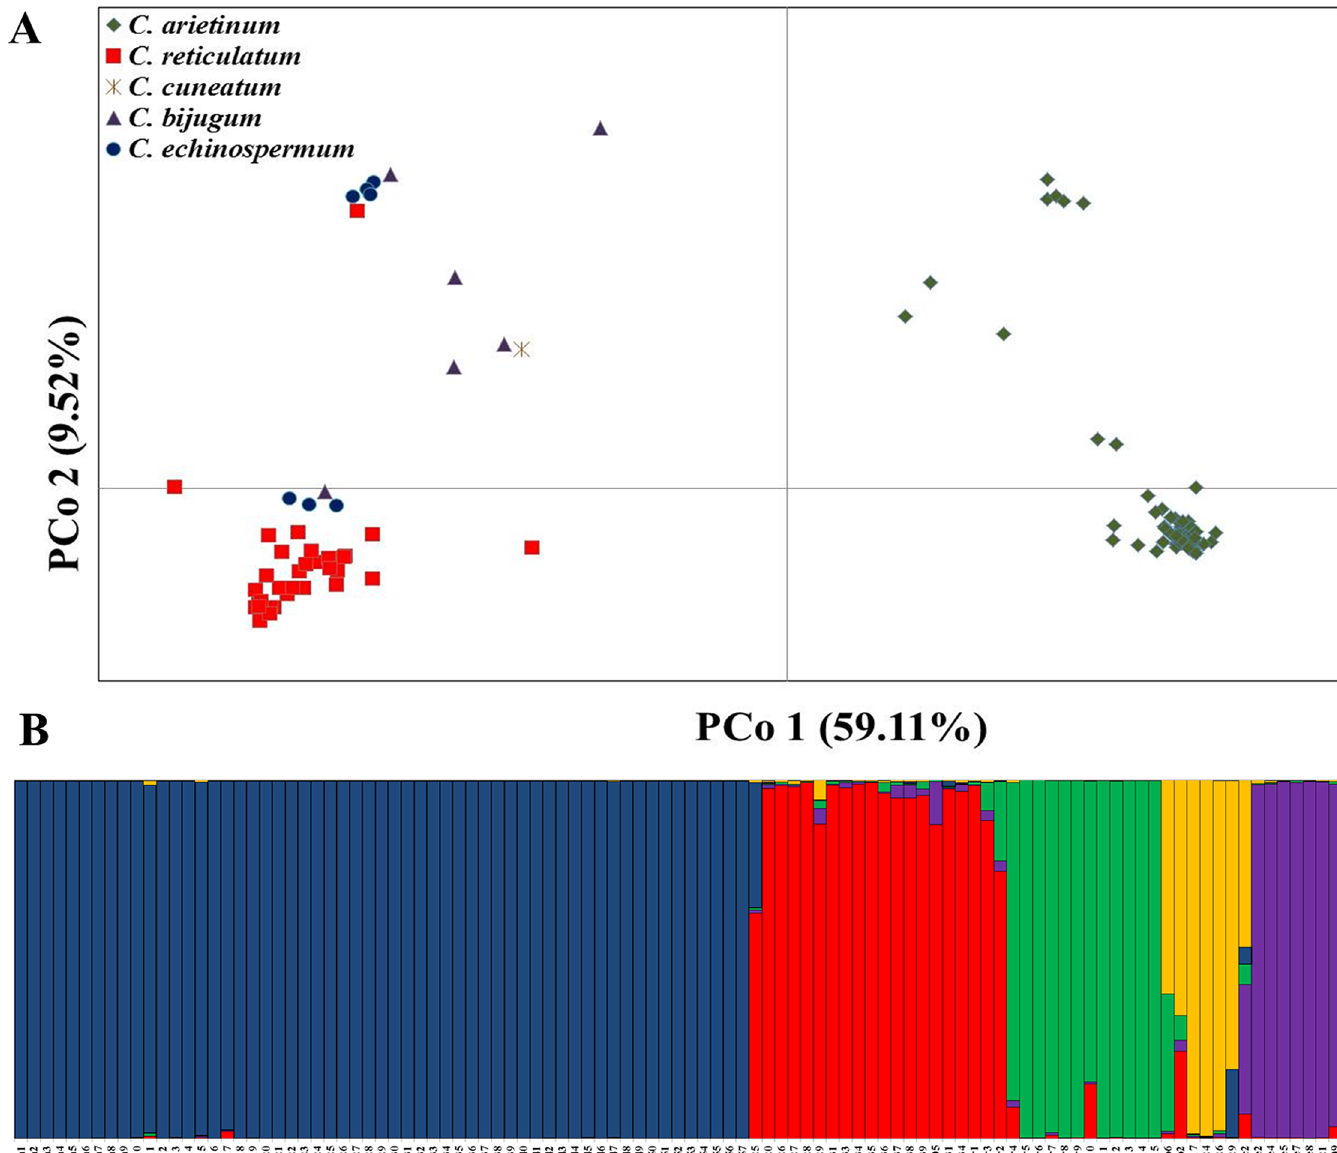
Fig 2. Genetic relationships between Cicer sp. (A) A principal coordinate (PCo) plot of pairwise individual genetic distances among four wild Cicer species and domesticated genotypes. (B) Estimated population structure based on allele frequency variation of SNPs markers. Each genotype is represented by a vertical bar, which is partitioned into K- colored components representing the ancestry fractions in K = 5 clusters. Individual genotypes are ordered by species (labeled